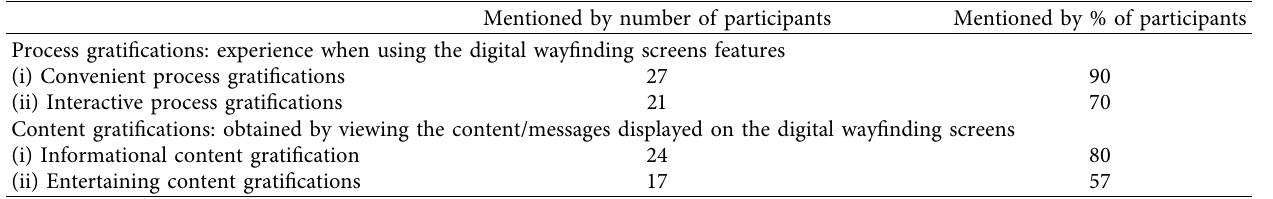
Table 3: Major themes of the findings. Mentioned by number of participants Mentioned by % of